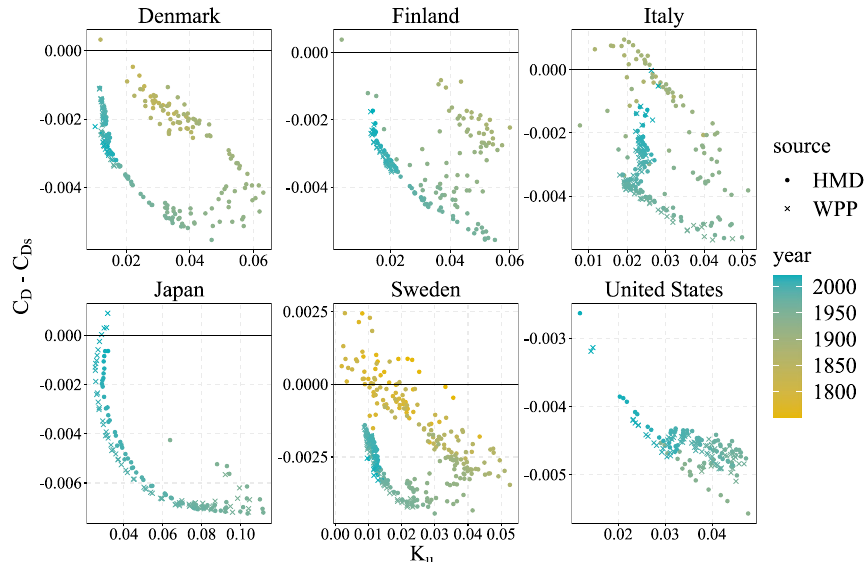
Fig. 9 The deviation ( K u ) and the sensitivity ( C D — C Ds ) in 6 countries from HMD and WPP,